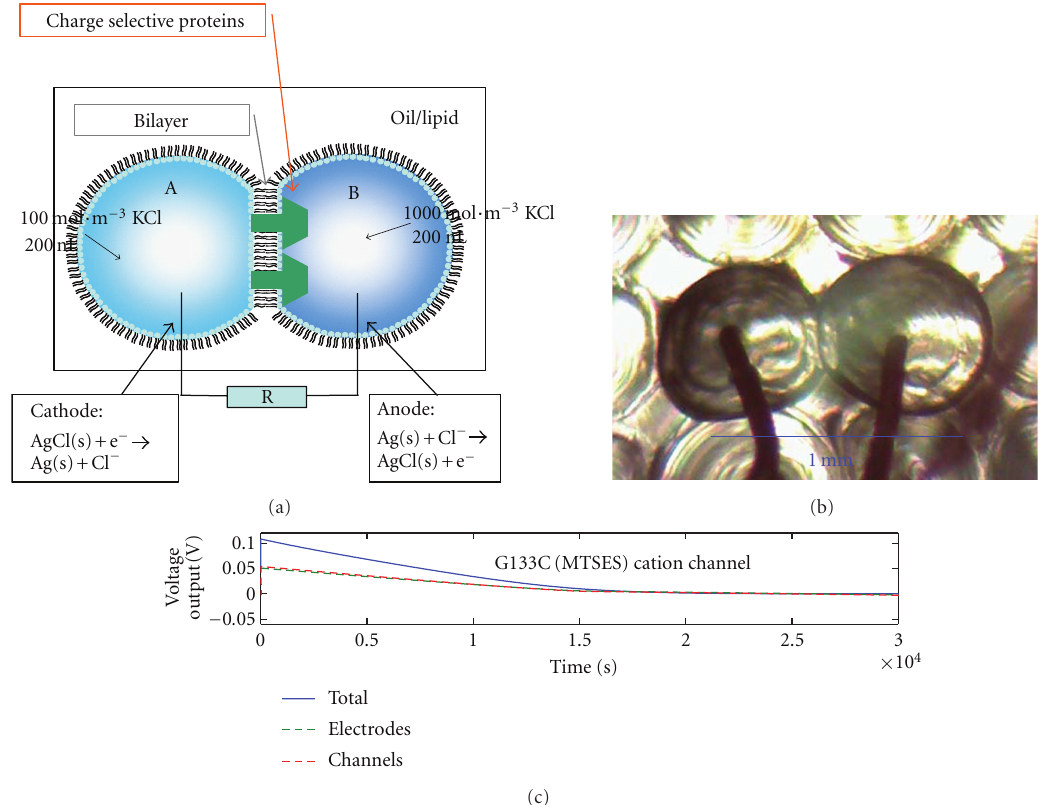
Figure 2: The electrogenic mechanism and performance of a protocell with DC output. (a) The schematic of this protocell (not drawn to scale) [2]; (b) the microscopic image of the structure of this protocell (scale bar: 1mm); (c) the calculated voltage output of this protocell using a cation-selective channel (MTSES-treated G133C α -HL mutant), based on published channel parameters [63]. The total